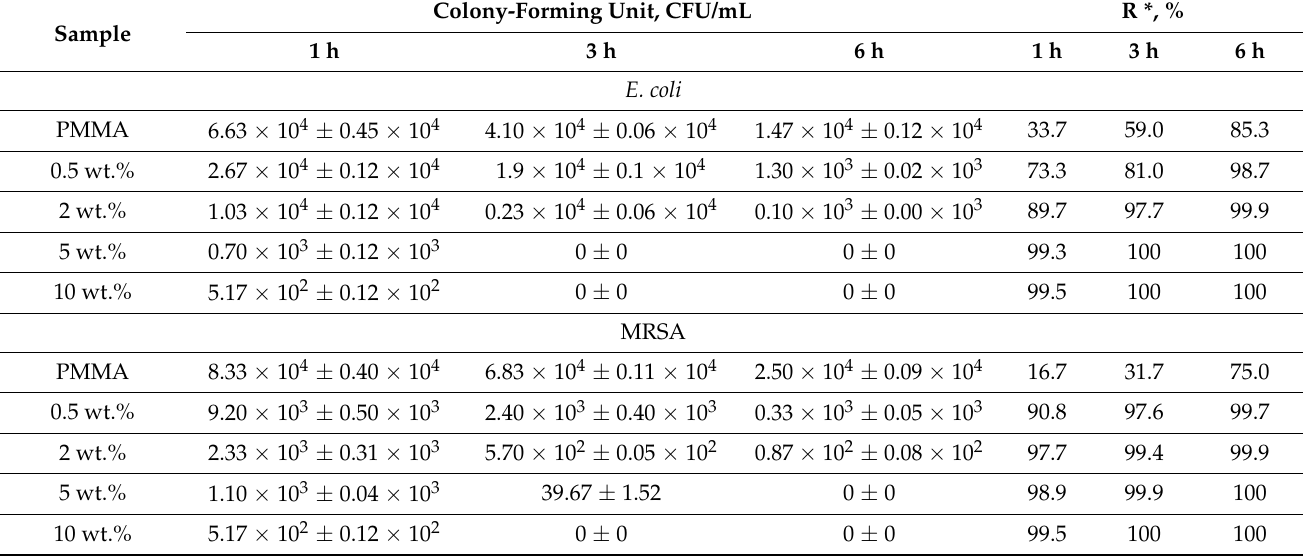
Table 2. Antibacterial activity of the